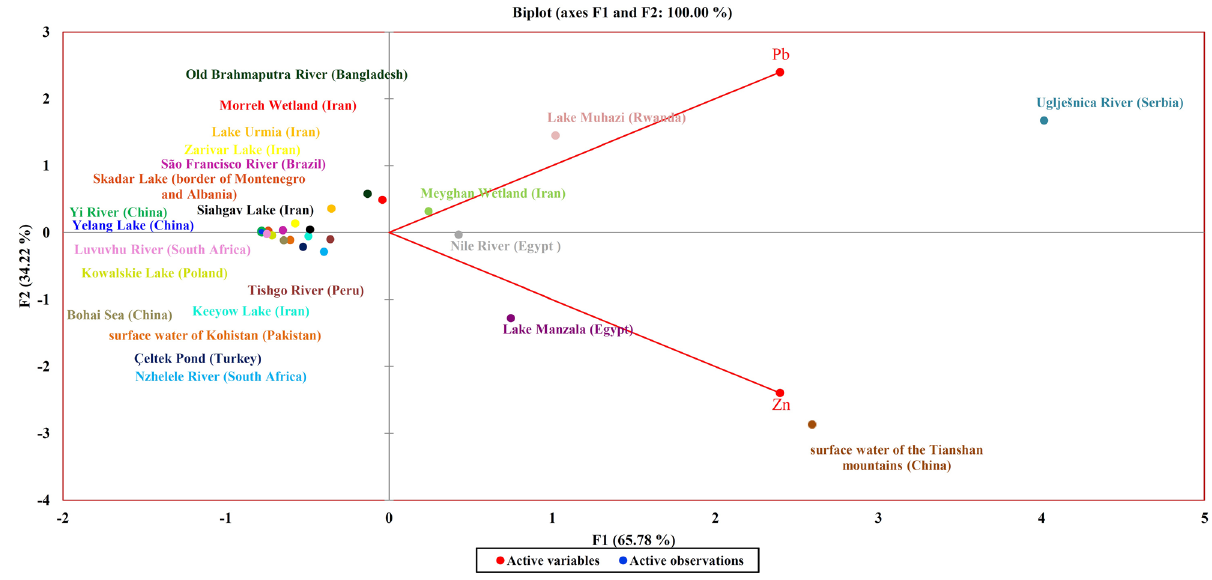
Figure 3. Comparison of different aquatic ecosystems (aquatic ecosystems studied herein and those from other studies worldwide) in terms of Pb and Zn concentrations in their water using